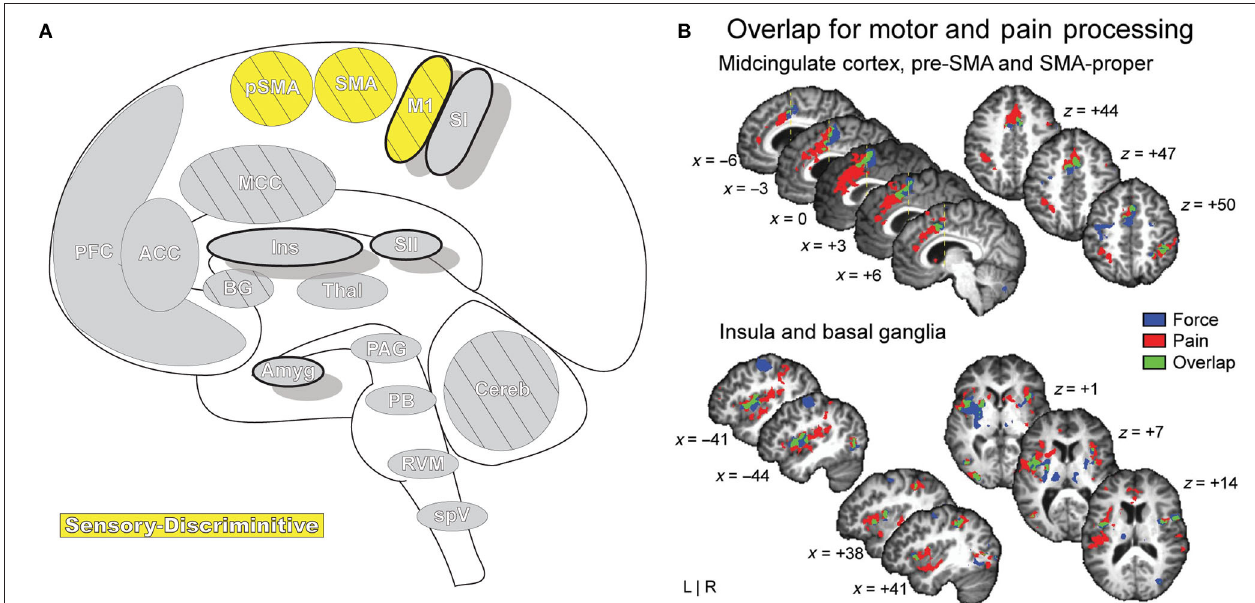
FIGURE 9 | Motor Areas. (A) Brain areas active during pain: primary motor area (M1), supplementary motor area (SMA/SMA-proper), pre-supplementary motor area (pSMA/pre-SMA) highlighted. (B) Functional activations associated with pain processing (painful heat: red) and motor control (force production: blue) overlap (green) in the SMA, pSMA, and aMCC, and display increased activation when simultaneously processing both conditions. Further results of the same group-level conjunction analysis describe overlap in pain and motor processes in the anterior insula and basal ganglia (putamen), reinforcing a dynamic established previously in the literature. Pain processes were established by painful thermal stimulation to the right hand; motor control processes were established by participants gripping a force transducer with their right hand. Reprinted from G Misra, SA Coombes, Neuroimaging Evidence of Motor Control and Pain Processing in the Human Midcingulate Cortex, Cerebral Cortex, Copyright (2014), Vol 25(7), p1906–19, by permission of Oxford University Press. DOI: